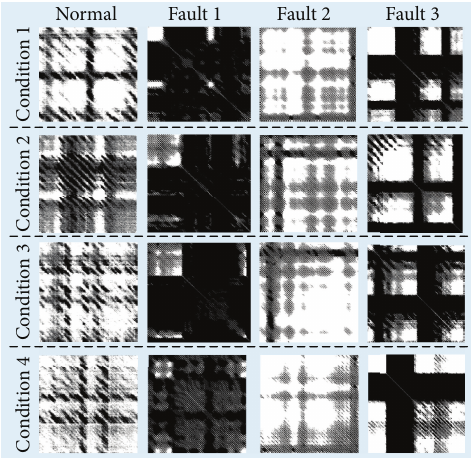
Figure 8: RPs transformed by fault mode vibration data under different conditions.